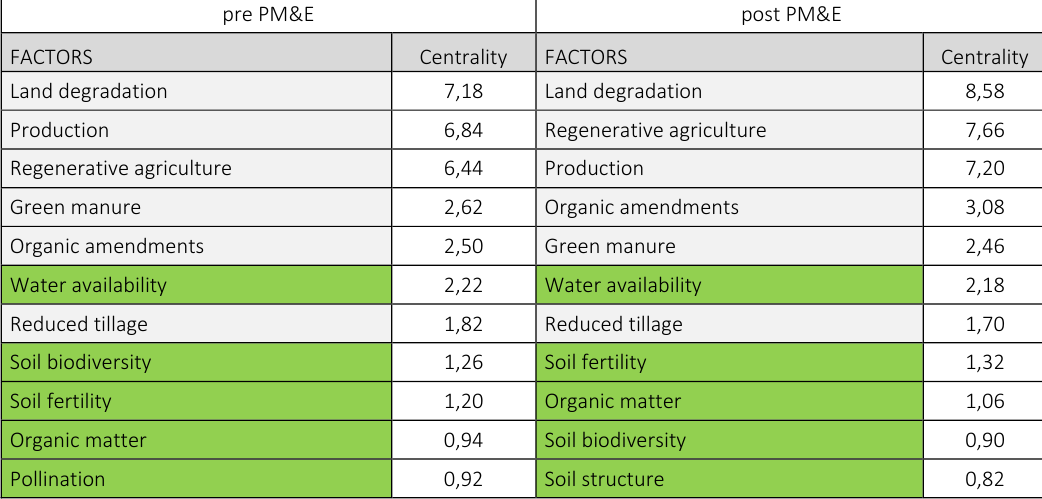
Table 3 Factors mentioned before and after PM&E organized from higher to lower centrality